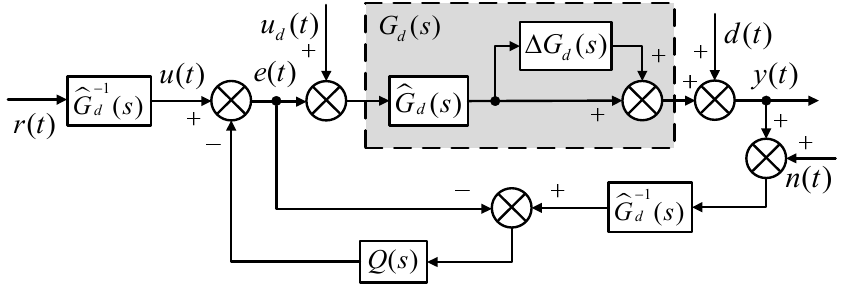
Figure 11. The feed ‐ forward inverse control combined with the disturbance observer. Figure 11. The feed-forward inverse control combined with the disturbance